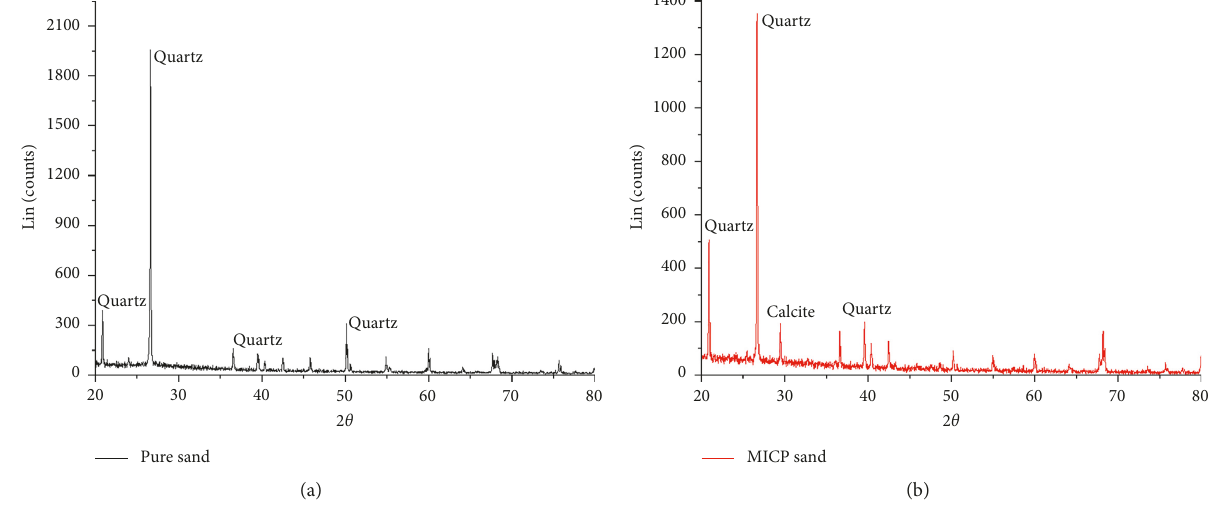
Figure 3: XRD patterns of the pure sand and the cemented sand.